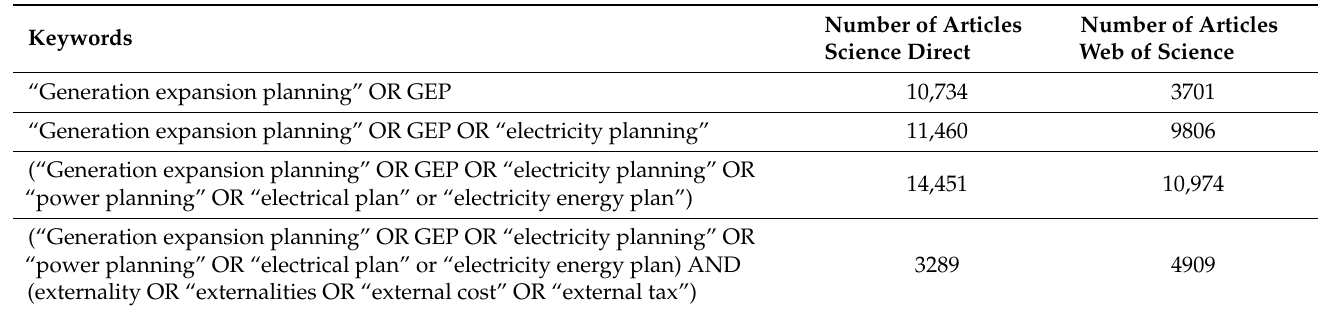
Table 1. Number of articles found in each filtering step based on keywords.